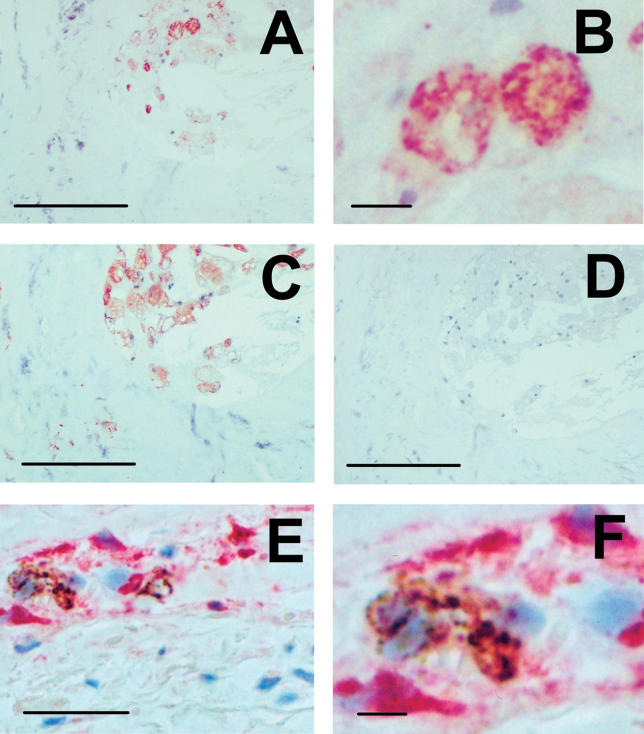
Identification of HIV-1–Positive Macrophages in Atherosclerotic Plaques of HIV-Infected Subjects.Single (A–D) and double (E and F) immunostaining of aortic wall segments.(A) p24 staining. A low-magnification image showing the presence of p24+ cells in an area adjacent to the plaque lipid core. The scale bar represents 100 μm.(B) Detail of (A). p24+ cells show a characteristic morphology of foam cells. The scale bar represents 10 μm.(C) CD68 staining. CD68+ cells were identified in a parallel consecutive section to that shown in (A). The scale bar represents 100 μm.(D) Negative control (staining with an irrelevant primary antibody). The scale bar represents 100 μm.(E) Double immunostaining showing the co-localization of p24 (brown) with CD68 (rose). Immunostaining included a combination of a rabbit polyclonal anti-p24 antibody in the peroxidase–anti-peroxidase system with DAB chromogen yielding a brown reaction product, and a mouse monoclonal antibody to CD68 in the alkaline phosphatase–anti-alkaline phosphatase system with Fast Red chromogen, resulting in a rose precipitate. Counterstaining was with Mayer's hematoxylin. The scale bar represents 50 μm.(F) A detail of (E). The scale bar represents 15 μm.